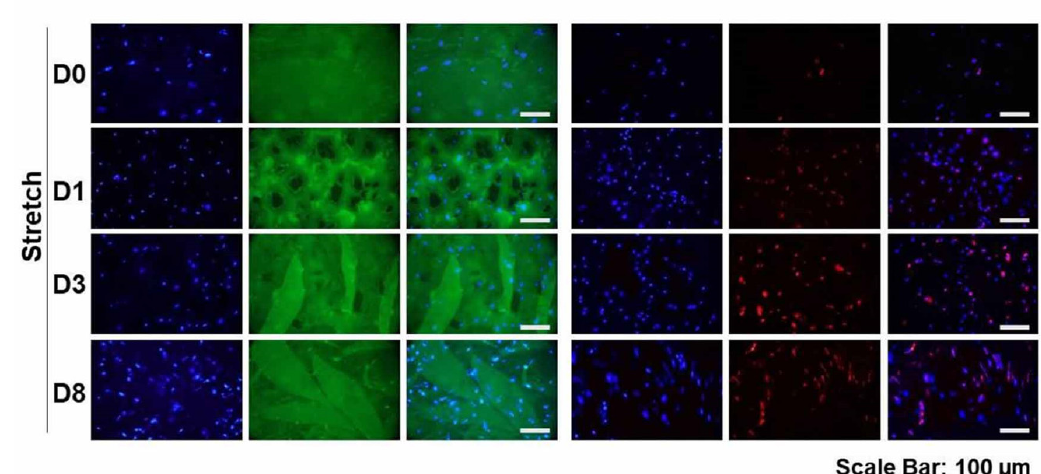
Figure 7. The fabrication process of magnetic hydrogel and the effect of magnetic bioreactor on magnetic hydrogel encapsulated myoblast cells. ( a ). Graphical presentation of the construction processes of the magnetic bioreactor in the 3D DLP printer. Silk-GMA + IO was used as a base layer bio-ink, while the top layers were printed with Gel-GMA + myoblast cells. Silk-GMA: methacrylated SF, Gel-GMA: methacrylated gelatin, GMA: glycidyl methacrylate, IO and O=Fe=O: iron oxide. ( b ). Fluorescence pictures exhibited myosin (MHC-green) and α -SMA (red) expressions for C2C12 cultured hydrogel in both static and stretched conditionThe alignment of the myotubes and α -SMA was similar to the direction of hydrogel. Adapted from [103] with the permission from IOP Pub- lishing Ltd.